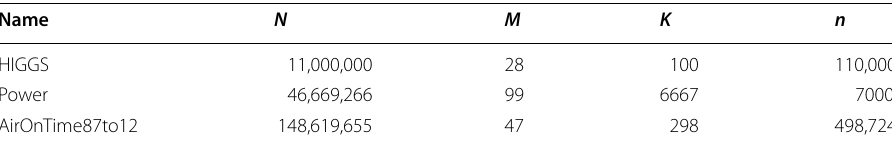
Table 1 Datasets